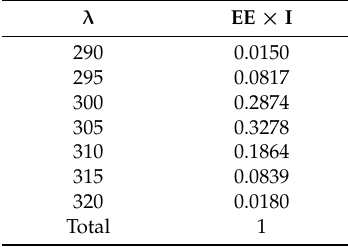
Table 2. Relationship between erythemal effect (EE) and radiation intensity (I) at each wavelength ( λ